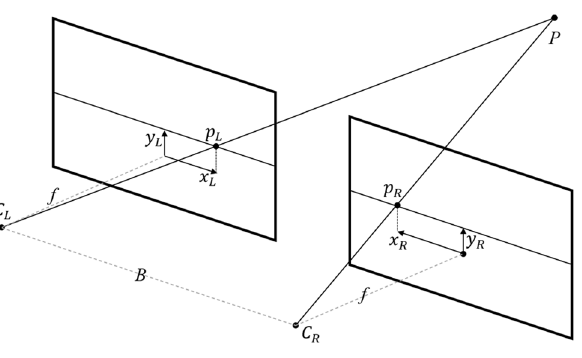
Figure 1. Geometric relationship of a stereo camera configuration. The 3D image of target scene at point P.